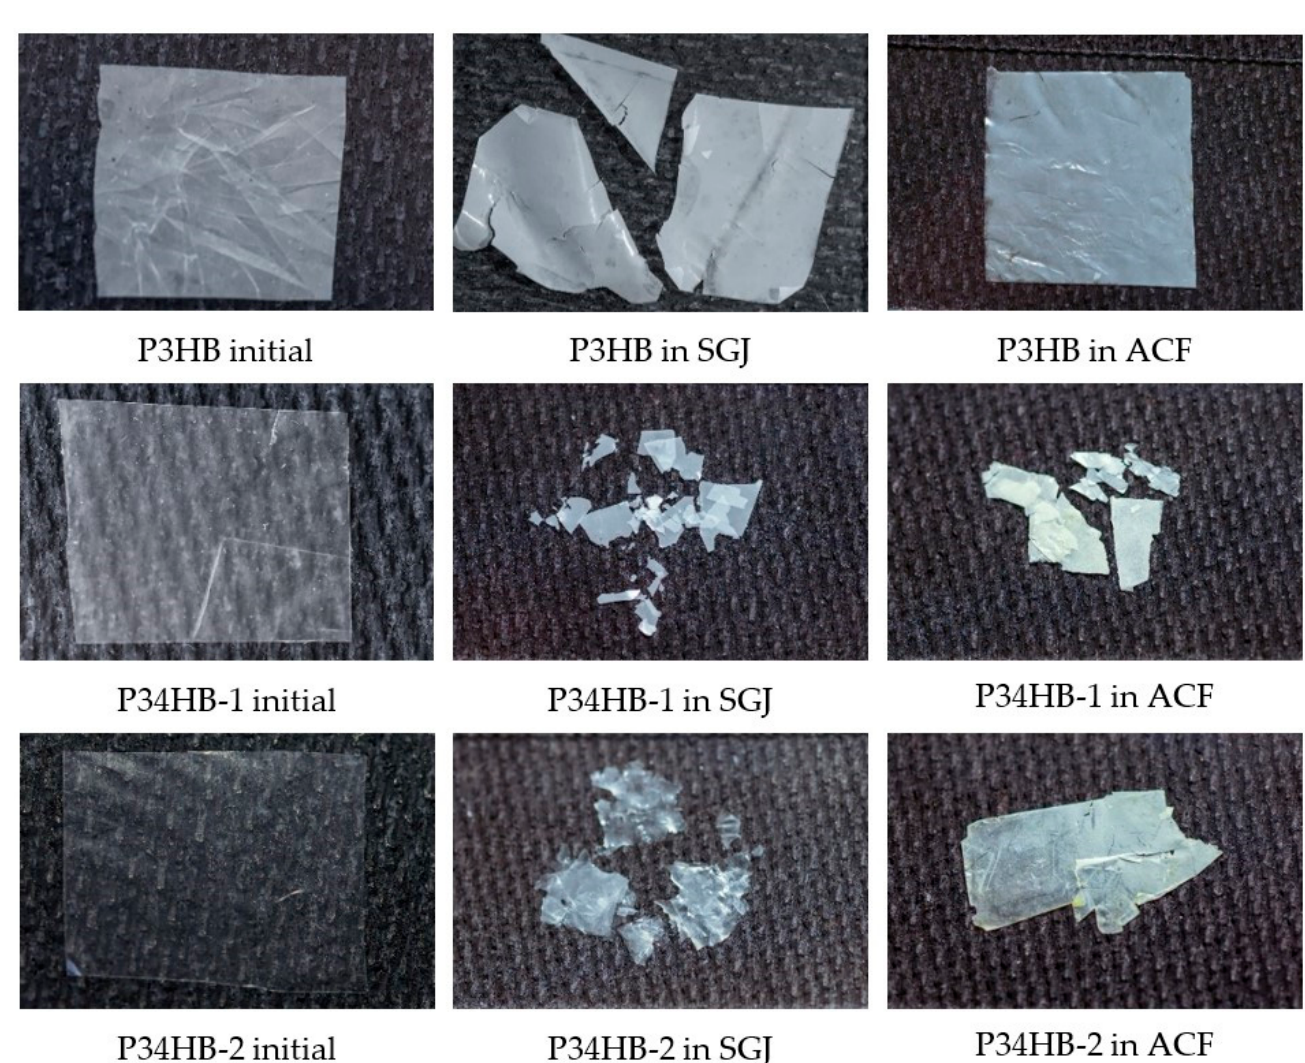
Figure 1. Changes in the morphology of the films at the end of incubation in SBFs.